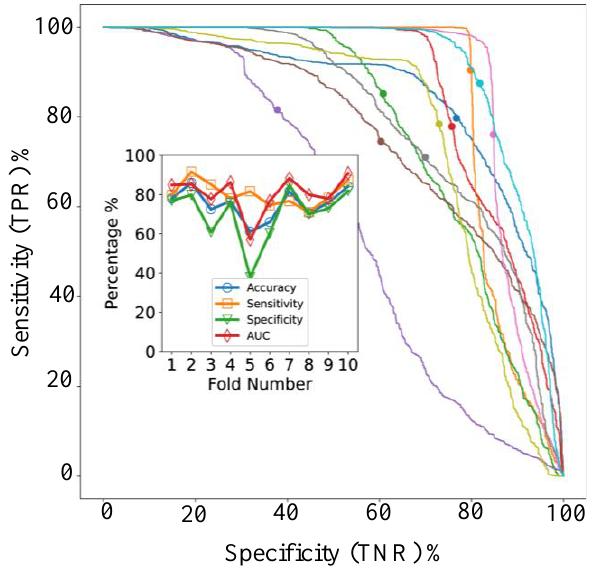
Figure 6. Endometrial cancer: 10-fold cross-validation results for per-spectra classification. The main figure shows the ROC-AUC curves (true positive rate (TPR) vs. true negative rate (TNR) for each fold. The solid circle on each curve shows the operating point for a classification threshold of 0.5. The total area under the curve (AUC) for each TMA is shown in the inset, along with the corresponding accuracy, sensitivity, and specificity. The different colors of the ROC-AUC curves indicate different cross-validation folds. The lines joining markers in the inset are a guide to the eye.